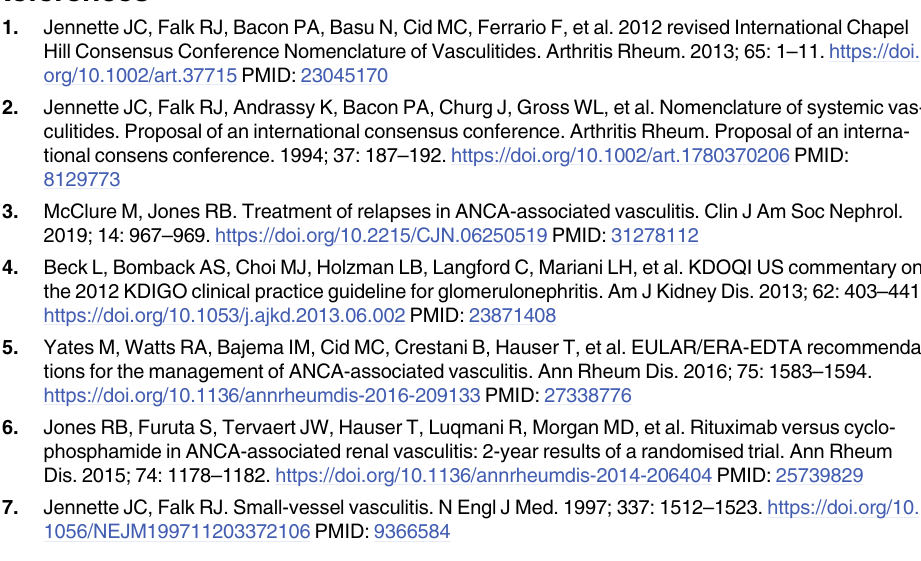
S3 Table. Predictors of the first relapse. S4 Table. Clinical characteristics of 69 patients who underwent renal biopsy compared on the basis of histologic